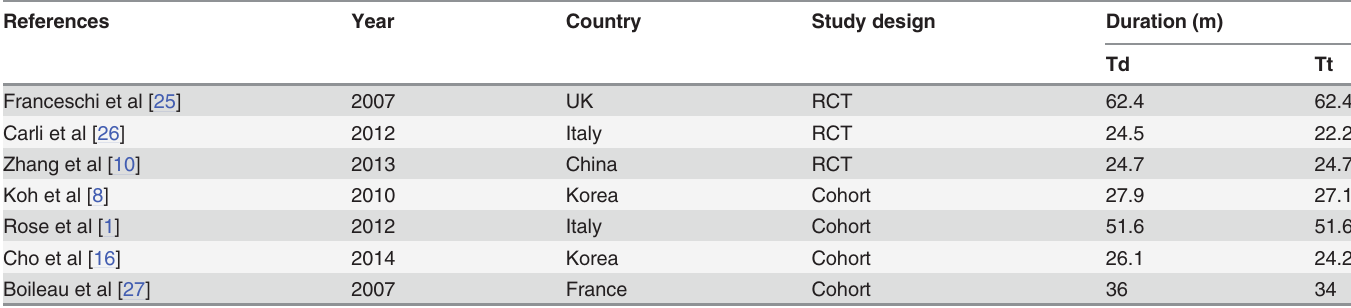
Table 1. Characteristics of studies included in this